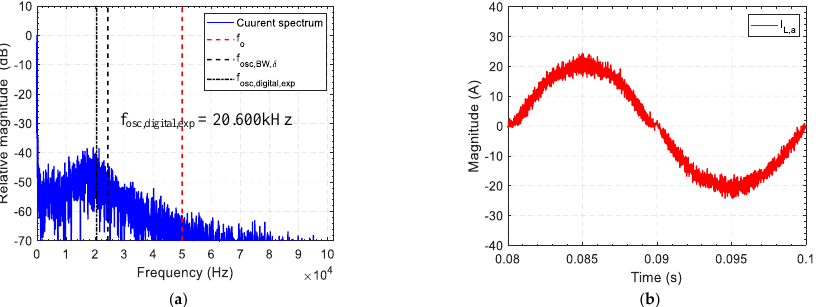
Figure 23. Simulation results under DPSSOCC control with DC/DC converter: ( a ) current spectrum and ( b ) input current.